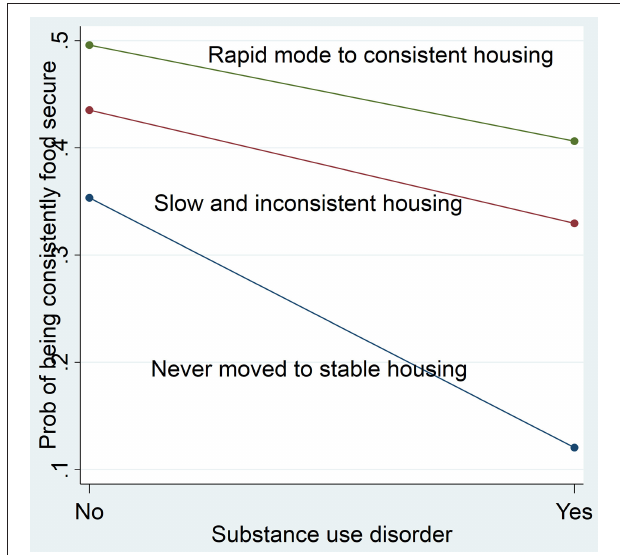
FIGURE 2 | Psychopathology modifies the effect of housing trajectory on food security.